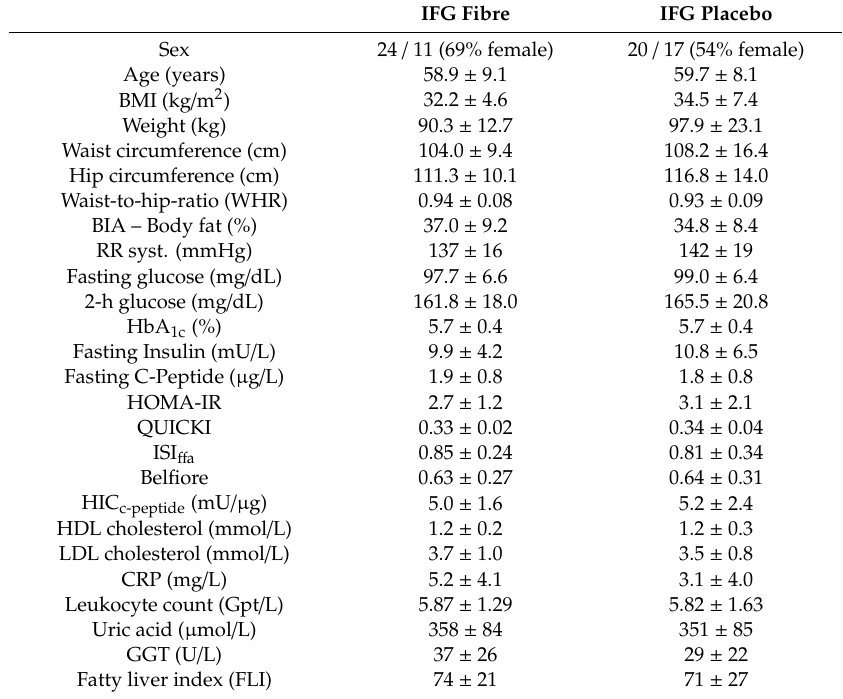
Table 2. Characteristics of participants at study entry (impaired fasting glucose (IFG) subgroups